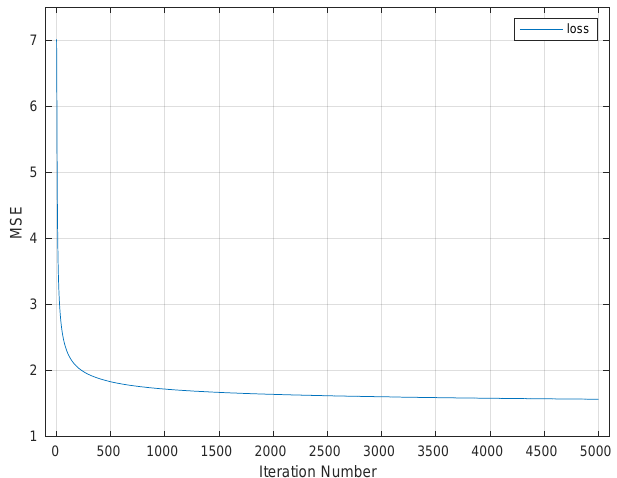
Figure 13. Mean squared error learning curve, Phase Two.